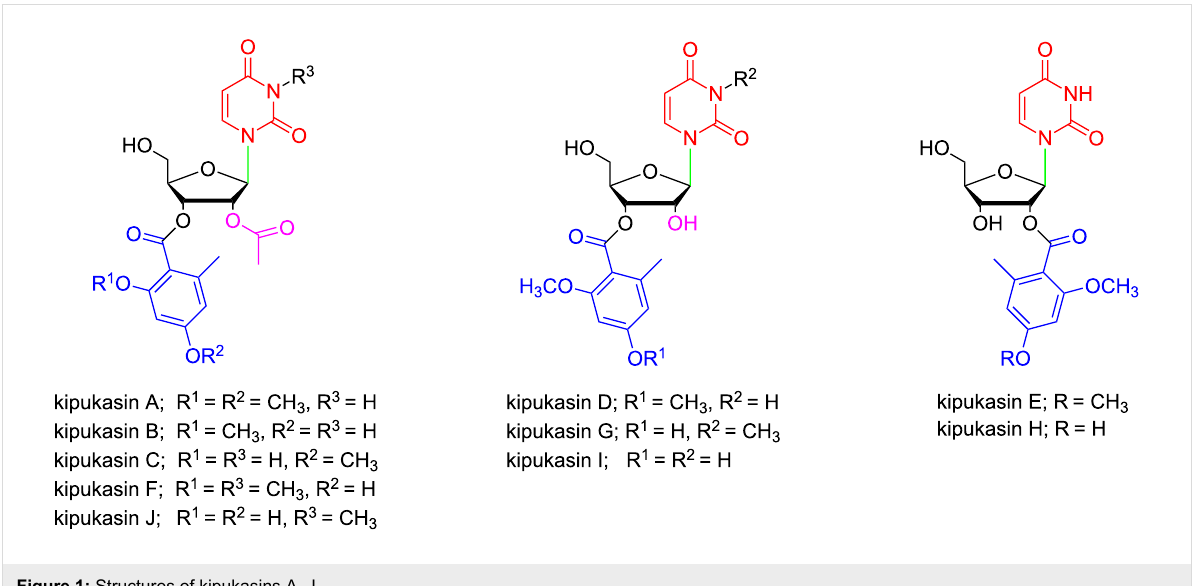
Figure 1: Structures of kipukasins A–J.